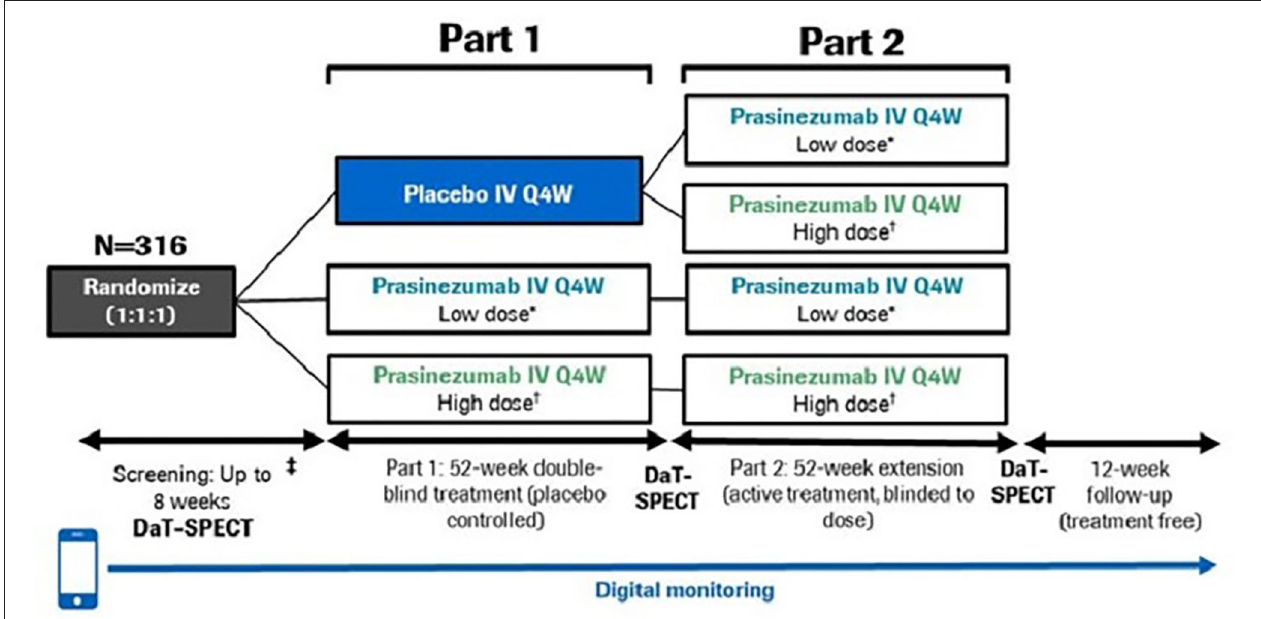
FIGURE 1 | PASADENA study design schematic. *Low dose = 1,500mg, † High dose = 4,500mg for ≥ 65kg; 3,500mg for < 65kg. DaT-SPECT, dopamine transporter imaging with single-photon emission computerized tomography; IV, intravenous; Q4W, every